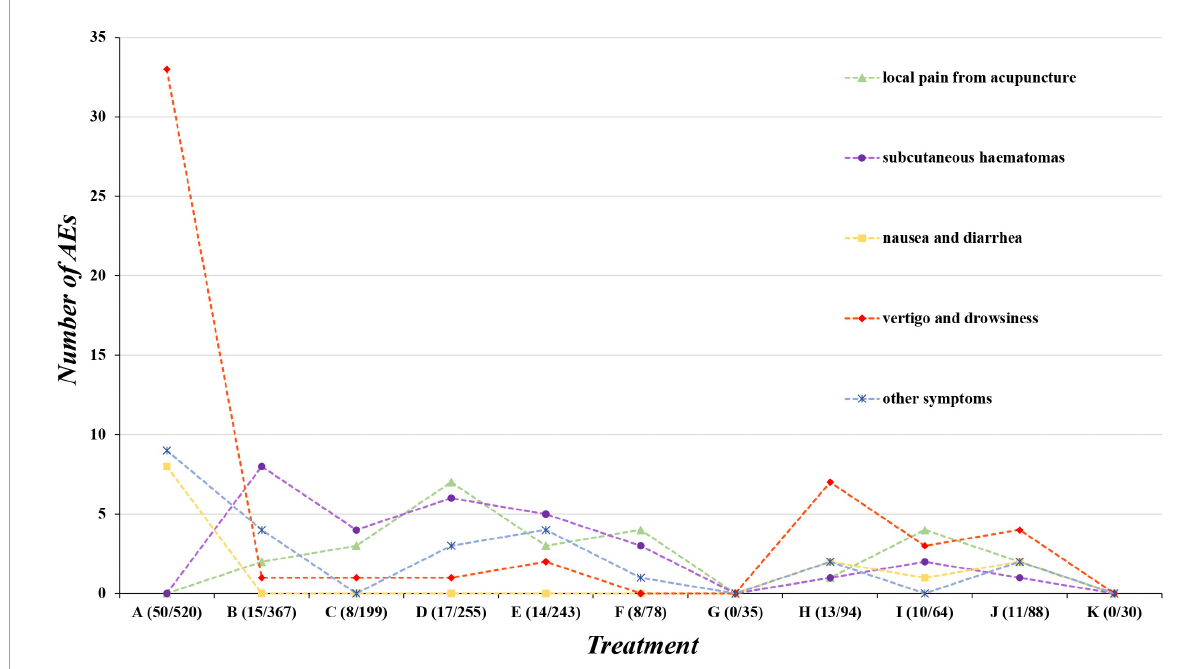
FIGURE9 Adverse events. A = antiepileptics; B = manual acupuncture; C = electroacupuncture; D = fire needling; E = pricking and cupping; F = Fu’s acupuncture; G = medicated thread moxibustion; H = electroacupuncture plus antiepileptics; I = fire needling plus antiepileptics; J = pricking and cupping plus antiepileptics; K = acupoint catgut embedding plus antiepileptics.